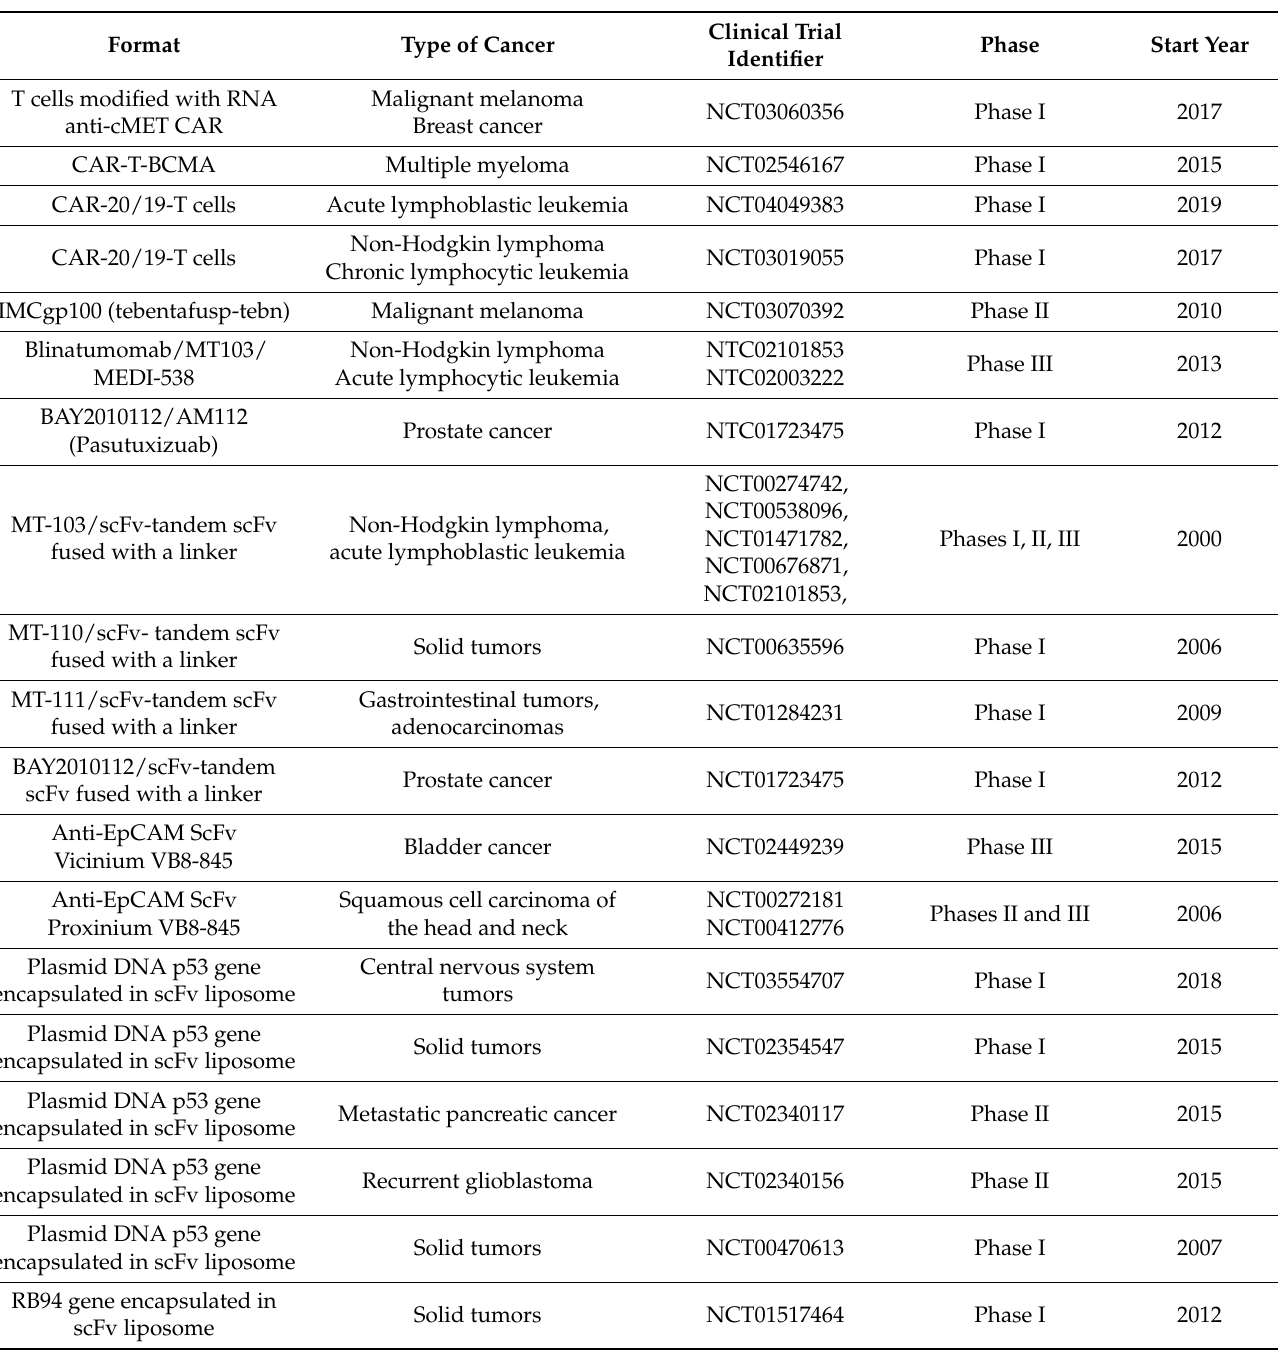
Table 3. Clinical trials of therapeutic agents against cancer with